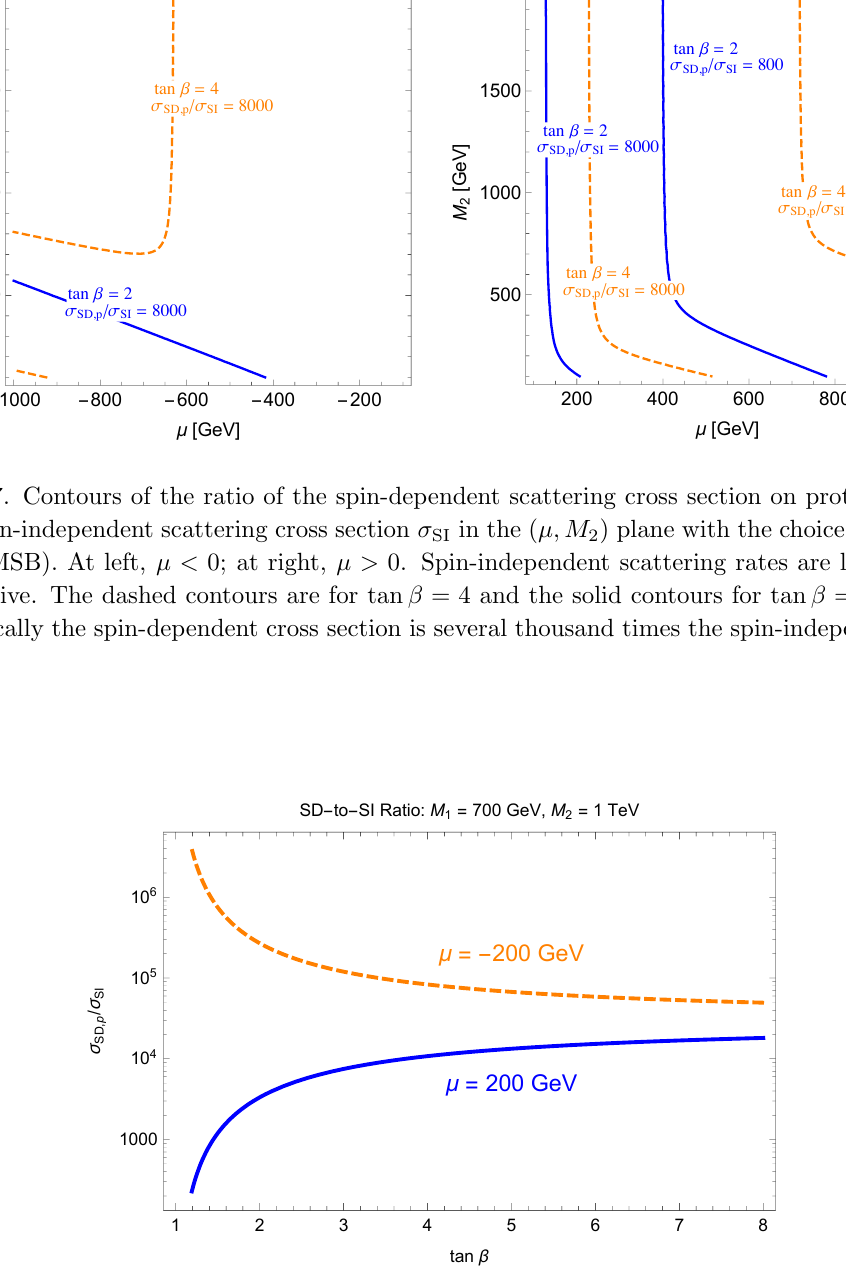
Figure 8 . The tan (cid:12) dependence of the cross-section ratio (cid:27) SD ;p =(cid:27) SI for a point in parameter space ( M 1 = 700 GeV, M 2 = 1000 GeV, j (cid:22) j = 200 GeV). At left, (cid:22) < 0; at right, (cid:22) > 0. When (cid:22) > 0, the ratio increases by a factor of 3.2 as tan (cid:12) increases from 2 to 4.